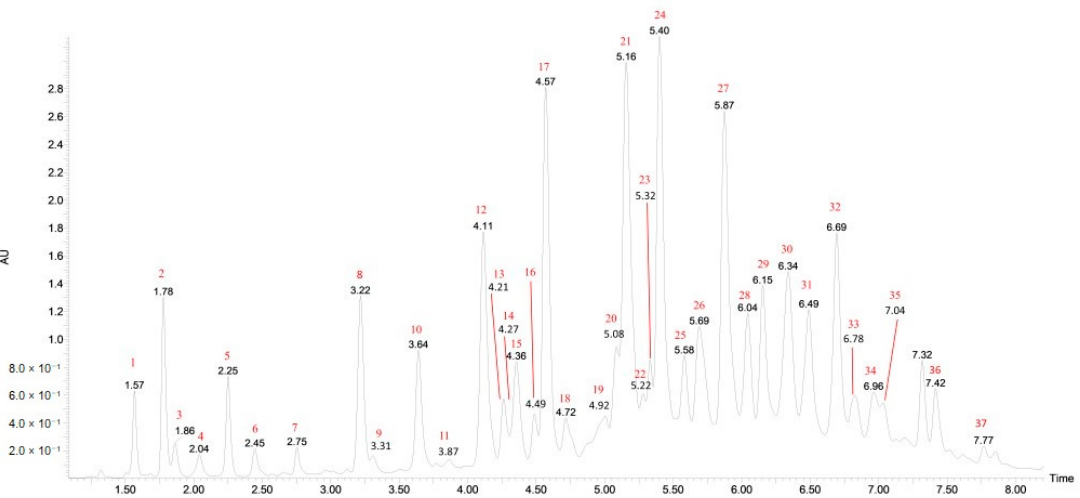
Figure 1. UPLC-PDA chromatogram of cornelian cherry stone extract at λ = 280 nm. Peak numbers refer to compounds listed in Table 1 and Table S1.